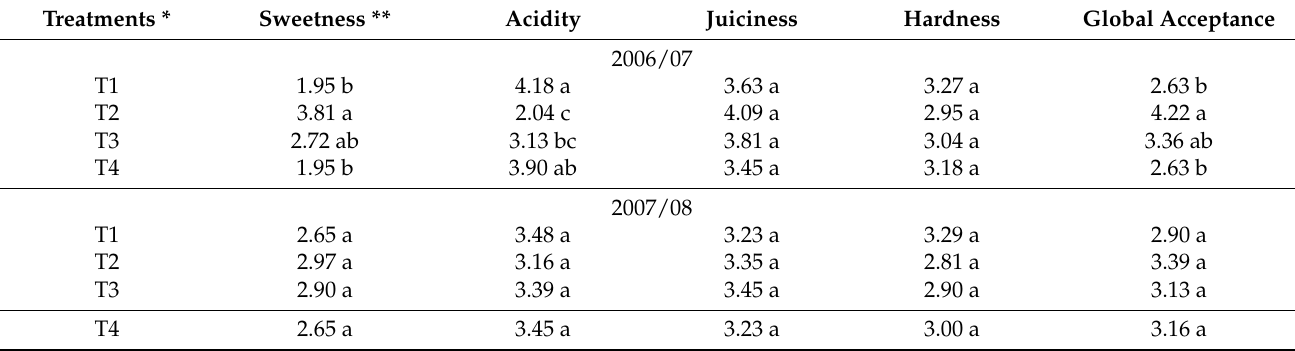
Table 7. Effects of deficit irrigation treatments on internal attributes scored by a sensory evaluation panel. Treatments * Sweetness ** Acidity Juiciness